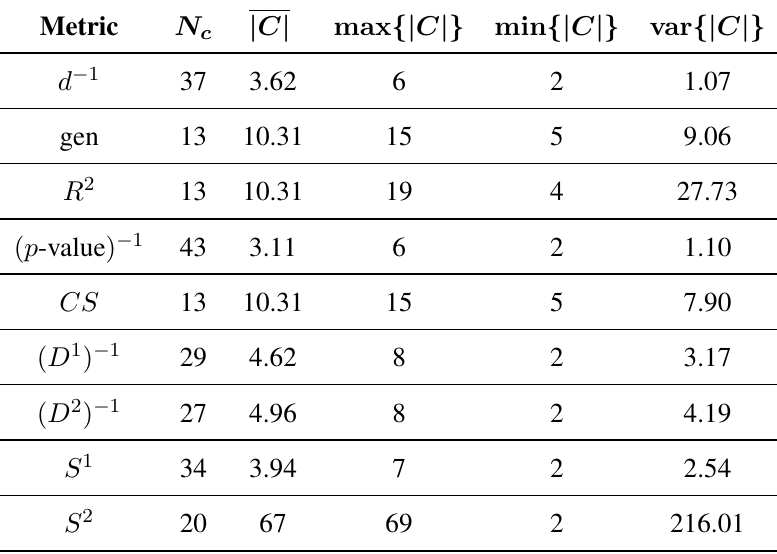
Figure 6. RP clusters and exemplars obtained on the DIET first floor with gen as the similarity metric (areas represented in different colors indicate different clusters; larger dots indicate exemplars). Table 1. RP clustering via affinity